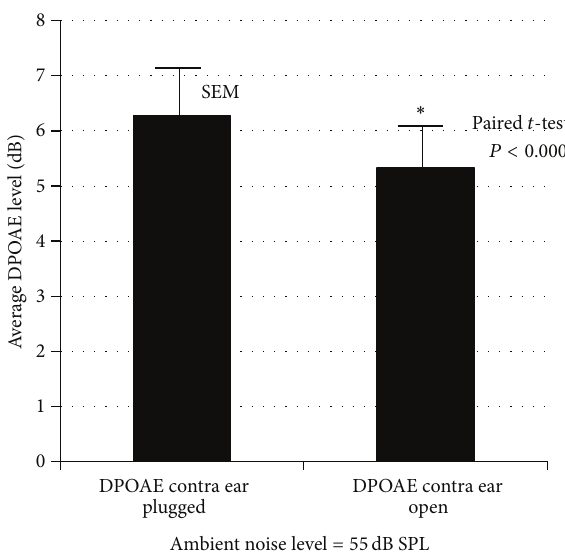
Figure 4: Average DPOAE level changes between contralateral ear open versus occluded conditions, measured in an environment with an ambient noise level of 55 dB SPL. Significant difference as indicated by paired Student’s 𝑡